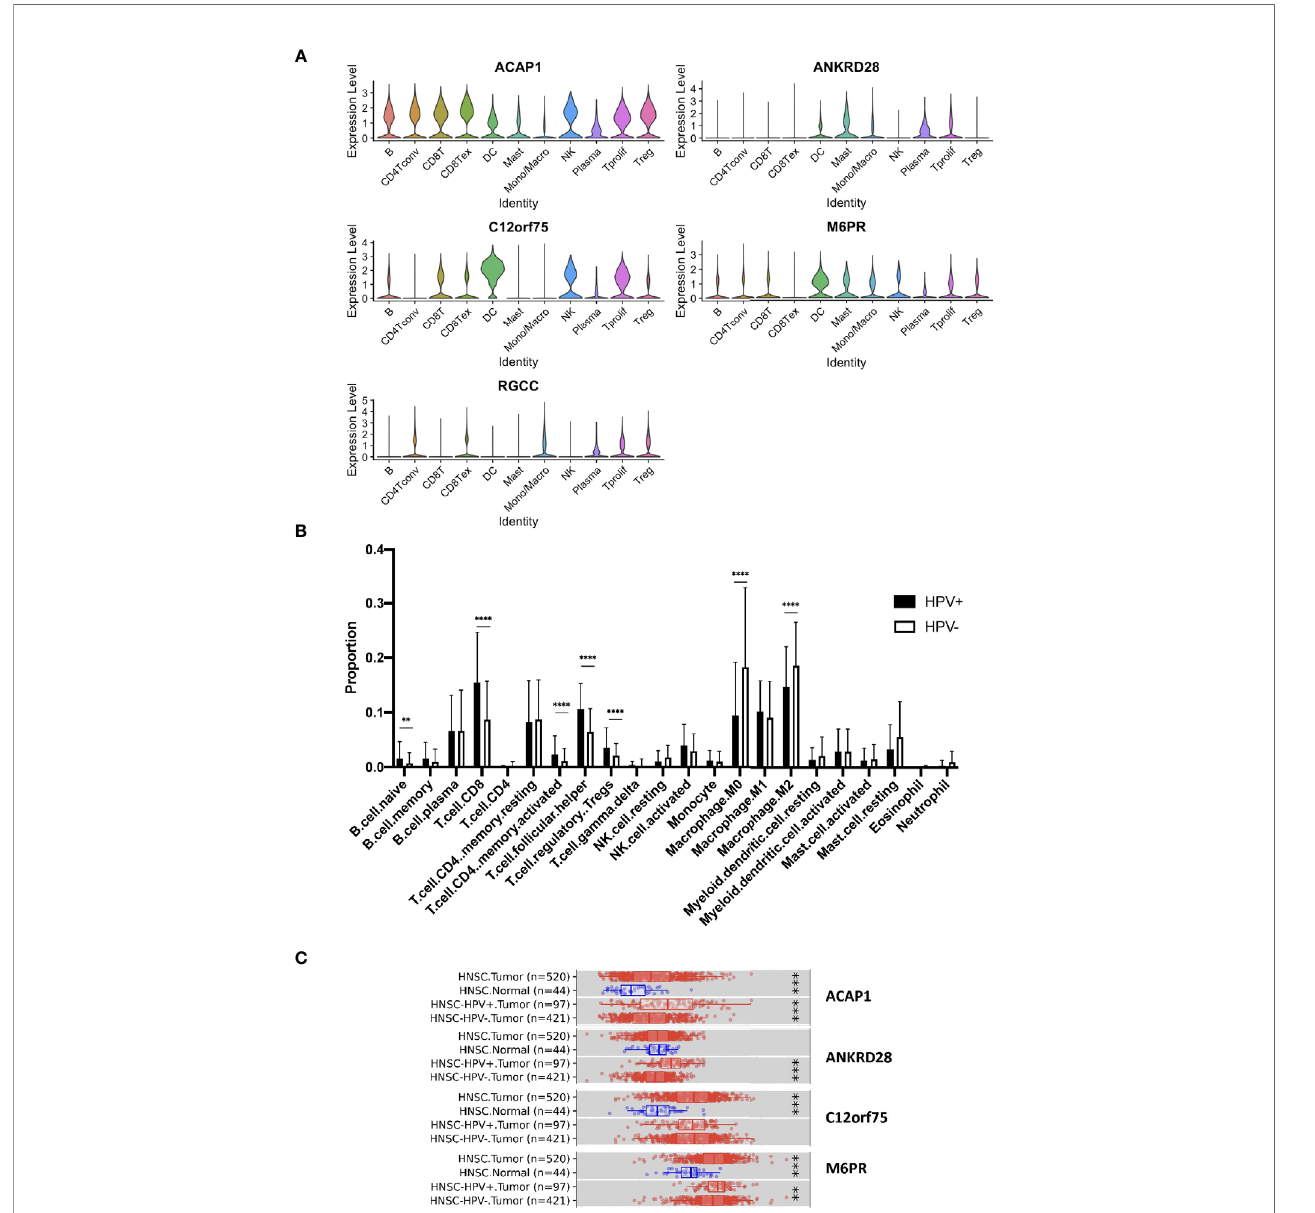
FIGURE 4 | Expression of the signature genes. (A) Violin plots illustrating the expression of the survival related signature genes in different TIL cell types of scRNA data. (B) Bulk seq data were deconvoluted using CIBERSORT method. Bar graph illustrating the proportion of in fi ltrated immune cells of HPV+ and HPV − HNSCC. (C) Expression of signature genes were analyzed using TIMER2 website. Box charts showed the expression of the signature genes of the TCGA data. “ ** ” refers p < 0.01, “ *** ” refers p < 0.001 and “ **** ” refers p <